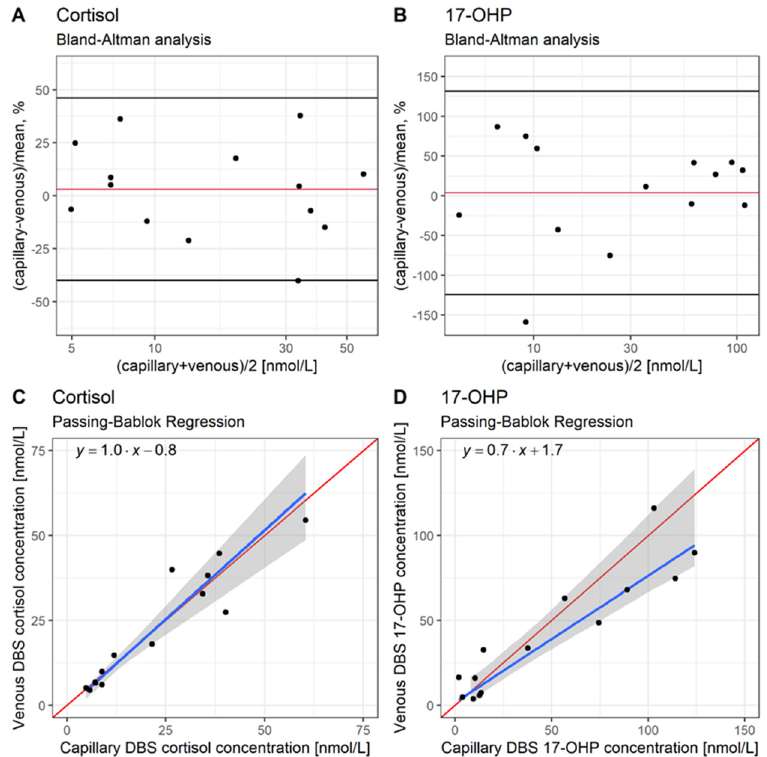
Figure 5. Comparison between capillary and venous cortisol ( A , C ) and 17 α -hydroxyprogesterone (17-OHP, A , D ) dried blood spot (DBS) concentrations, obtained from 15 pediatric congenital adrenal hyperplasia (CAH) patients. ( A , B ): Bland–Altman analysis. Capillary-venous/mean of difference [%] versus the mean of capillary venous cortisol and DBS 17-OHP concentrations. Red line: Mean difference [%], black lines: Mean difference—1.96*SD (standard deviation) and mean difference + 1.96*SD [%]. ( C , D ): Passing–Bablok regression. Red line: line of identity, blue line: regression line, gray area: 95% confidence interval for the regression line.